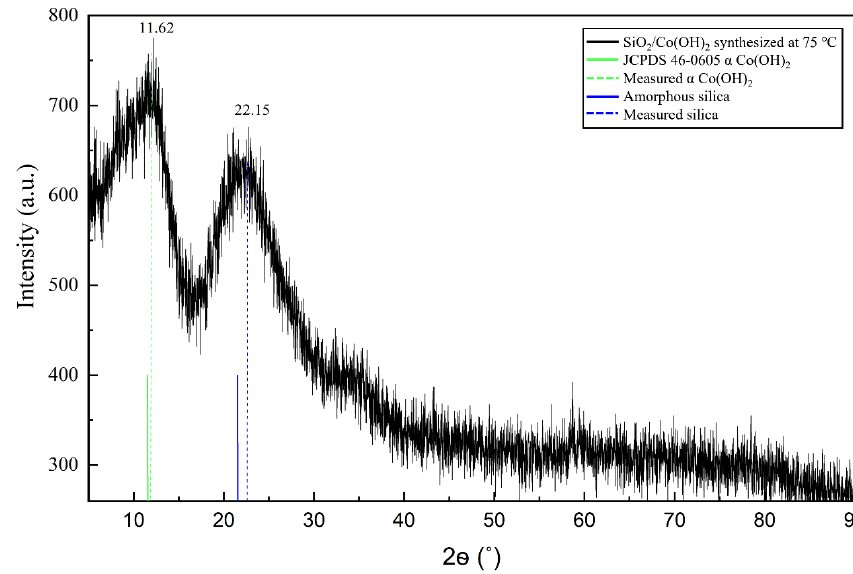
Figure 5. Powder XRD pattern for SiO 2 /Co(OH) 2 synthesized at 75 °C.